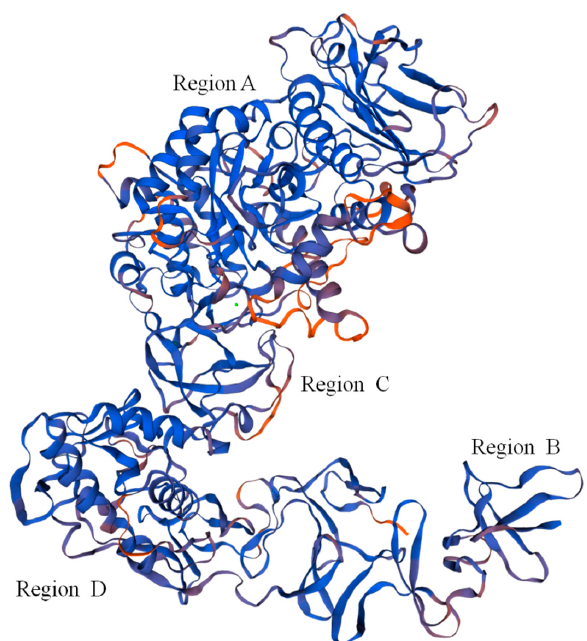
Figure 8. Predicted tertiary structure of dextransucrase (Dsr) translated from the dsr gene.